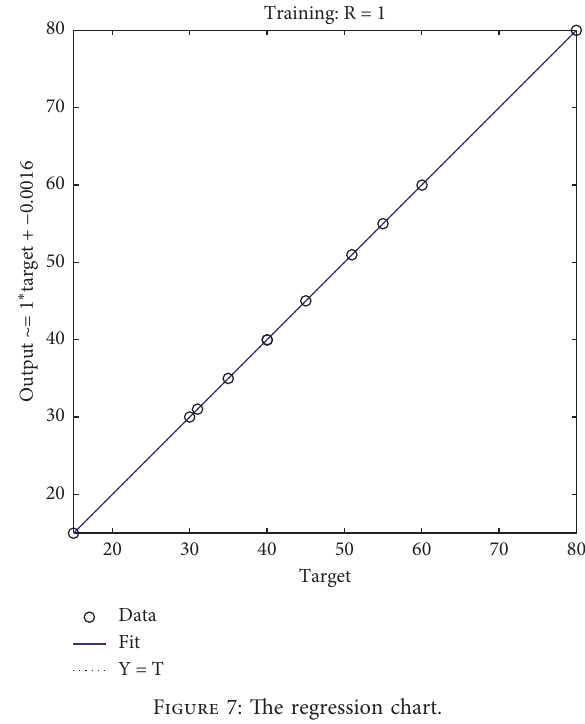
Figure 7: The regression chart. Table 6: The execution time of P